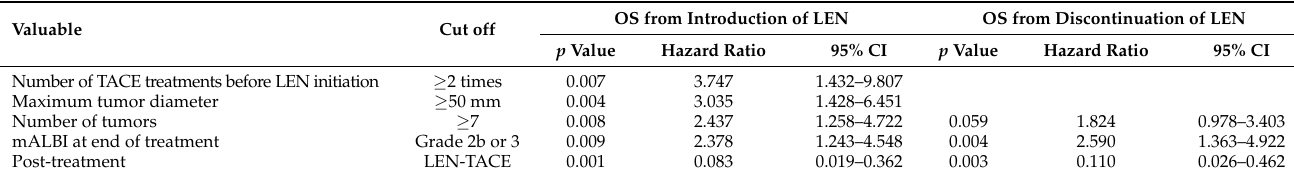
Table 3. Factors associated with the overall survival (n = 85).